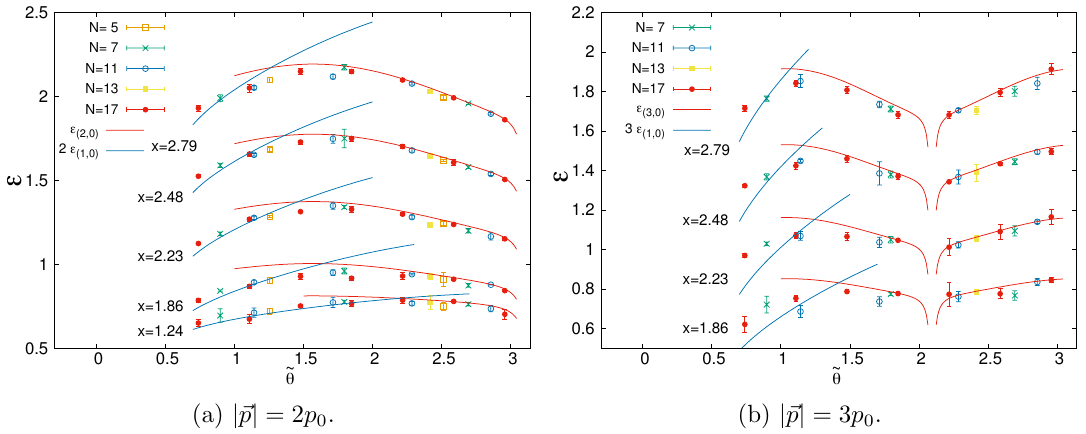
Figure 6. Dependence of E on ~ (cid:18) , for states with momentum j ~p j = 2 p 0 and 3 p 0 at several values ( n; 0) of x . The results at di(cid:11)erent values of x are displaced vertically by 0.4 starting from the lowest displayed value of x . The continuous lines in the plot represent E p eq. (3.6) with (cid:31) 0 = 0 : 6, and (cid:27) 0 =(cid:21) = 0 : 213.